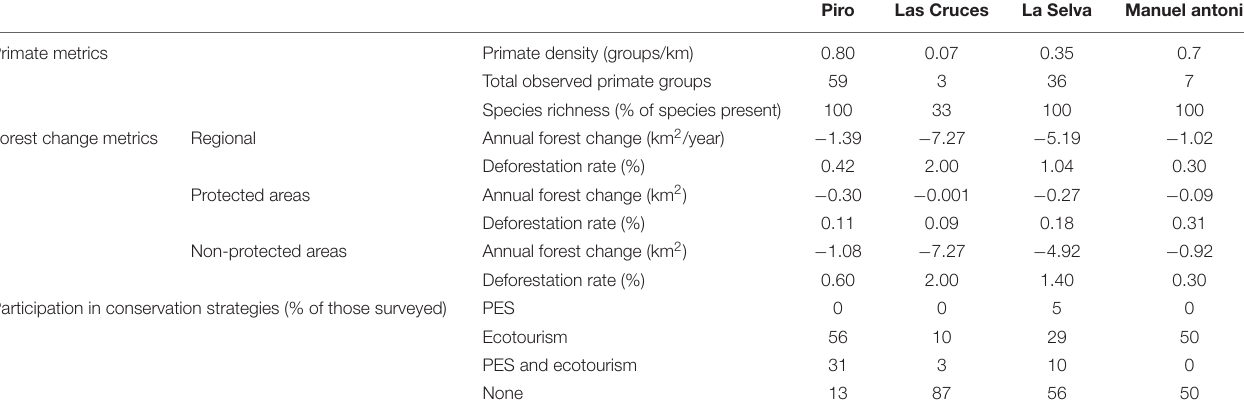
Piro Las Cruces La Selva